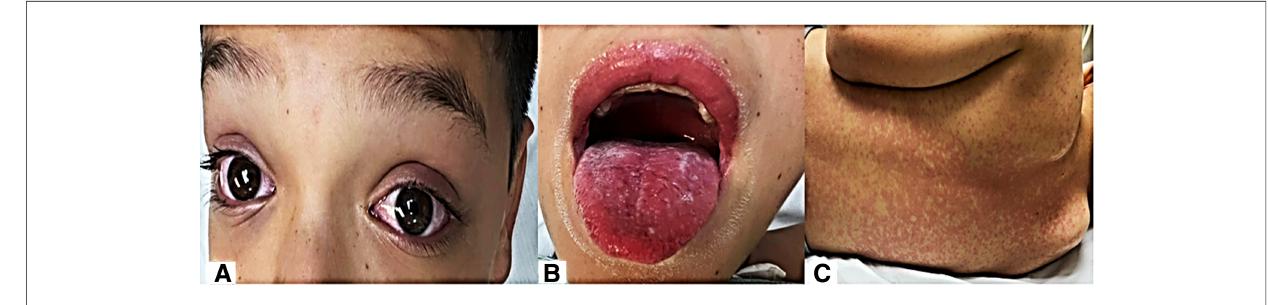
FIGURE 2 ( A ) Bilateral nonsuppurative conjunctival injection; ( B ) hyperemic oral mucosa and tongue; and ( C ) erythematous maculopapular